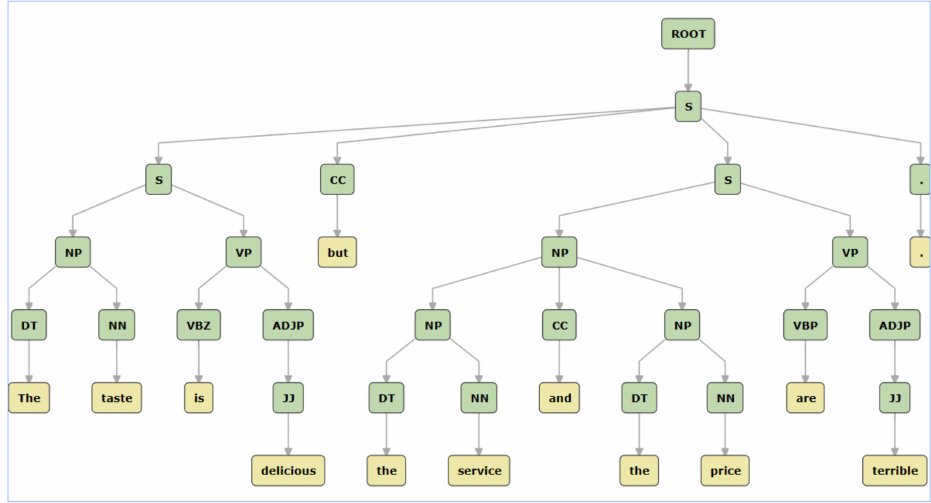
Figure 3. The result of constituent tree